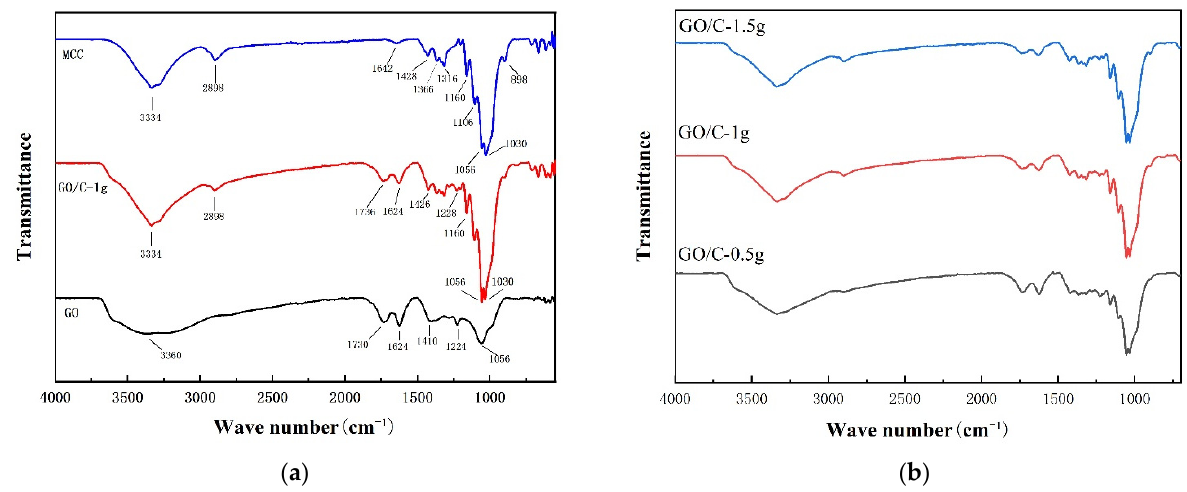
Figure 1. The FTIR spectra of ( a ) microcrystalline cellulose (MCC), graphene oxide (GO), GO plus 0.5 g MCC composite (GO/C-1 g); ( b ) GO plus 0.5 g MCC composite (GO/C-0.5 g), GO plus 1 g MCC composite (GO/C-1 g), and GO plus 1.5 g MCC composite (GO/C-1.5